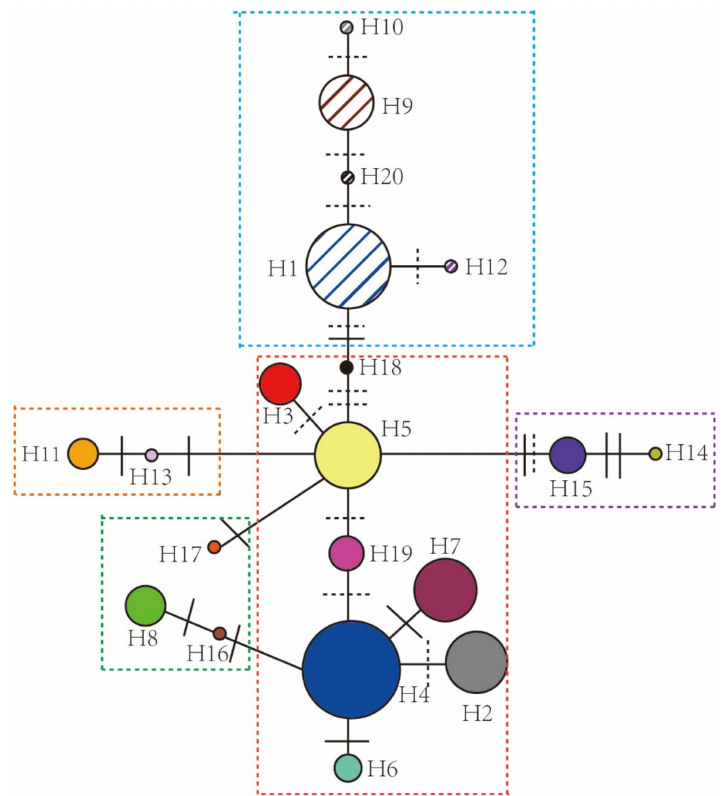
Figure 2. Network of cpDNA haplotypes detected in L. formosana . Note: The sizes of circles are proportional to the individual number of haplotypes, with the smallest circle representing n = 1, while the largest represents n = 50. The solid line indicates a nucleotide mutation step interlinking two haplotypes, and the dotted line indicates an indel mutation step. Each line indicates one mutation